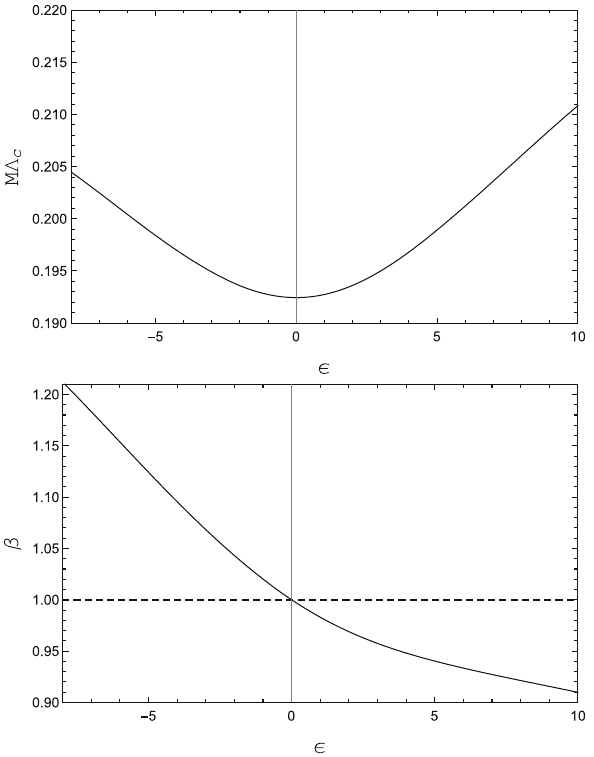
Fig. 9 Top: Lyapunov exponent Λ c atthe unstable circularorbit radius r c , as a function of ε . Bottom: β factor as a function of ε . When the deformation parameter vanishes the β factor is equal to 1